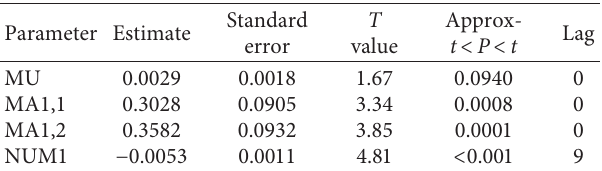
Table 2: Estimated results of the revised RDL model for green finance. Parameter Estimate